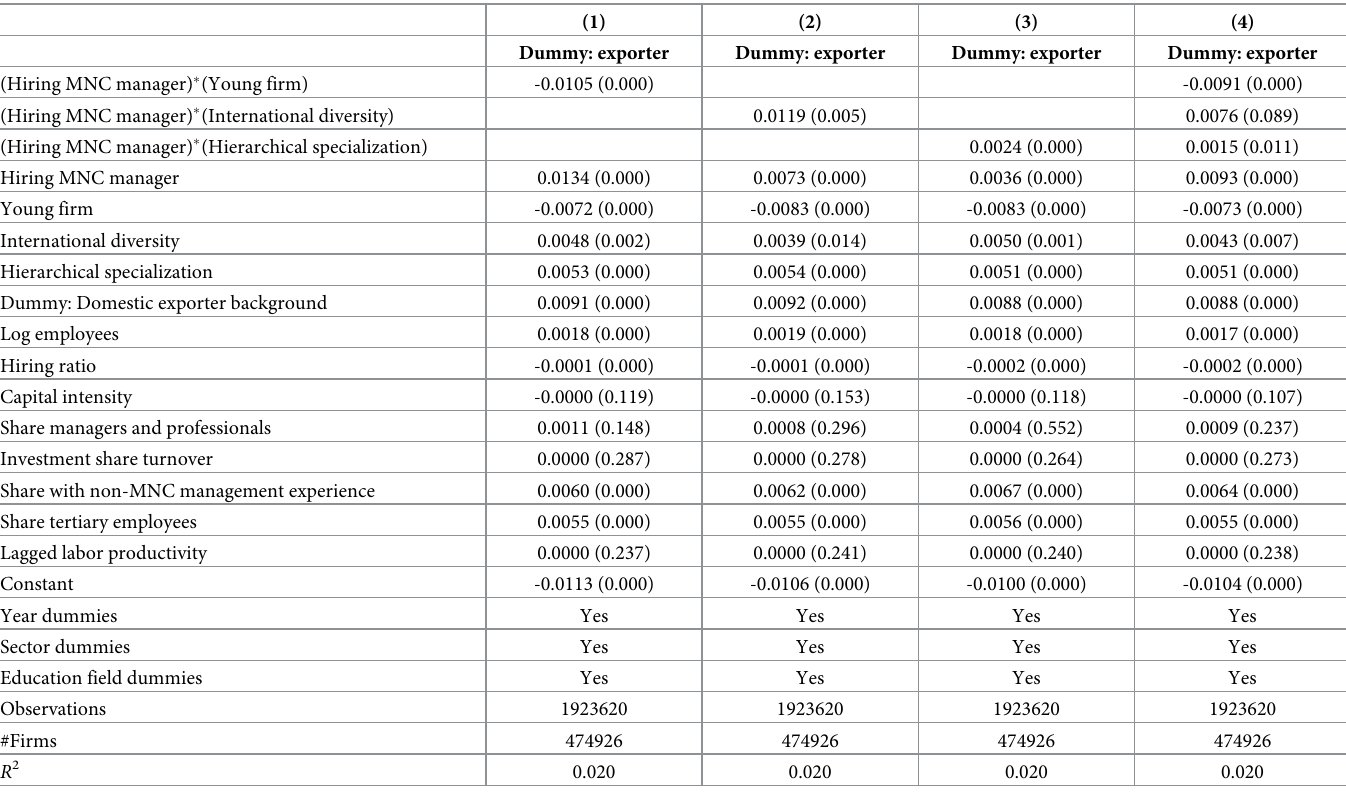
Table 4. Interaction OLS regressions for H1-H3 (dependent var: Dummy: